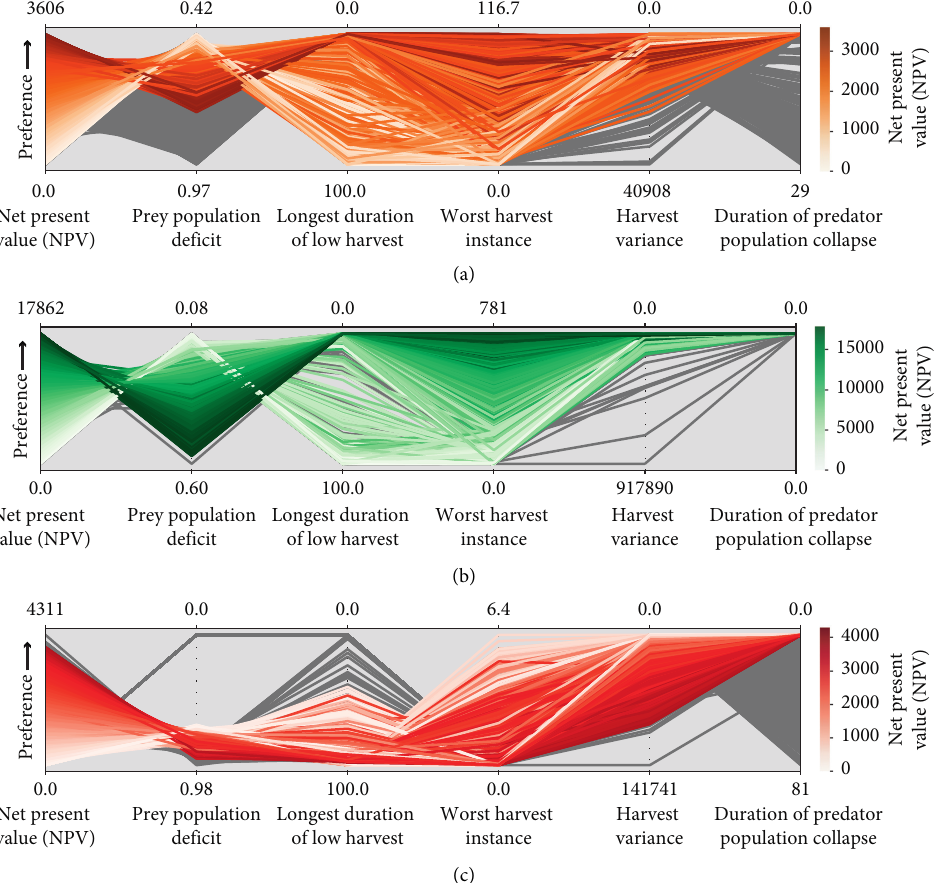
Figure 5: Solutions re-evaluated in three SOWs and solutions optimized to those SOWs, in a parallel coordinate form. (a) Nearby SOW with a global attractor. Orange: solutions optimized in this SOW and grey: solutions identified in assumed SOW and re-evaluated in this SOW. (b) Distant SOW with a global attractor. Green: solutions optimized in this SOW and grey: solutions identified in assumed SOW and re- evaluated in this SOW. (c) Nearby SOW without a global attractor. Red: solutions optimized in this SOW and grey: solutions identified in assumed SOW and re-evaluated in this SOW. The parameter values for each SOW are provided in Table